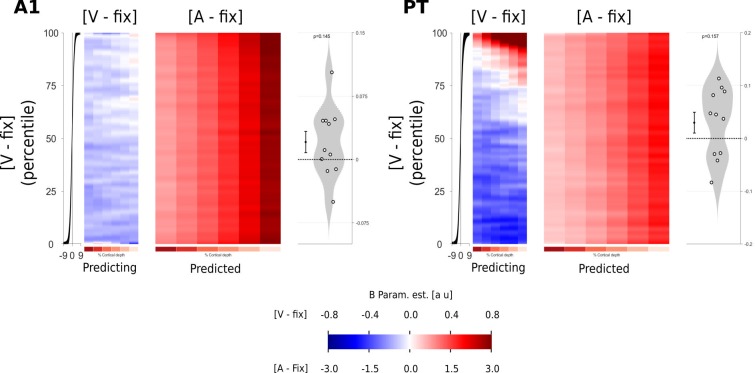
Raster plots for auditory induced activations and visual induced deactivations in auditory areas.The raster plots illustrate the statistical relationship between the ‘constant’ shape parameters for the visual evoked response [V-Fix]AttA, AttV and auditory evoked response [A-Fix]AttA, AttV in A1 (left) and PT (right). Each raster plot shows the laminar profiles (colour coded along abscissa) of the vertices for the ‘predicting contrast’ [V-Fix] and of the ‘predicted contrast’ [A-Fix]. The vertex profiles were sorted along the ordinate according to the value of the ‘constant’ shape parameter for [V-Fix]. The raster plot shows that the laminar profile of a vertex for [V-Fix] cannot predict its laminar profile for [A-Fix]. To enable averaging the raster plots across participants, the vertices were binned after sorting (number of bins for A1: 10100, number of bins for PT: 6800). For visualization purposes, all raster plots were smoothed along the vertical axis (FWHM = 1% of the number of data bins). The subplot (i.e. black line) to the left of the raster plots shows the across subjects’ mean value (+ /- STD) of the shape parameters (i.e. i. constant, ii, linear) of the sorting contrast. The violin plot show the distribution across subject of beta values for ‘a’ in the regression model [A-Fix]=a [V-FIX] + b. n = 11.